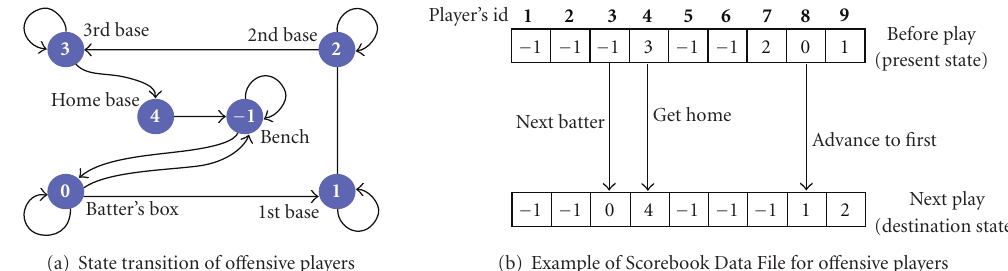
Figure 8: Actions of the o ff ensive players.